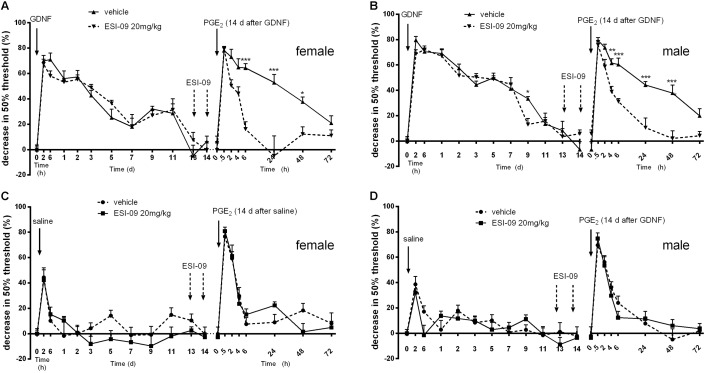
Effect of ESI-09 on GDNF-induced hyperalgesic priming. Female (A,C) and male (B,D) mice were treated with two oral doses (arrows) of ESI-09 (20 mg/kg in corn oil) or vehicle on days 13 and 14 after GDNF priming or saline. One hour after the last ESI-09 administration, the GDNF-primed mice received an intraplantar injection of PGE2 (100 ng/paw). The 50% paw withdrawal thresholds were monitored over time. Data are expressed as mean ± SEM. n = 8/group. (A), F = 26.41; (B), F = 33.49; (C), F = 2.31; (D), F = 0.58; DFn = 1, DFd = 280. Bonferroni’s multiple comparisons test: ∗P < 0.05, ∗∗P < 0.01, ∗∗∗P < 0.001.